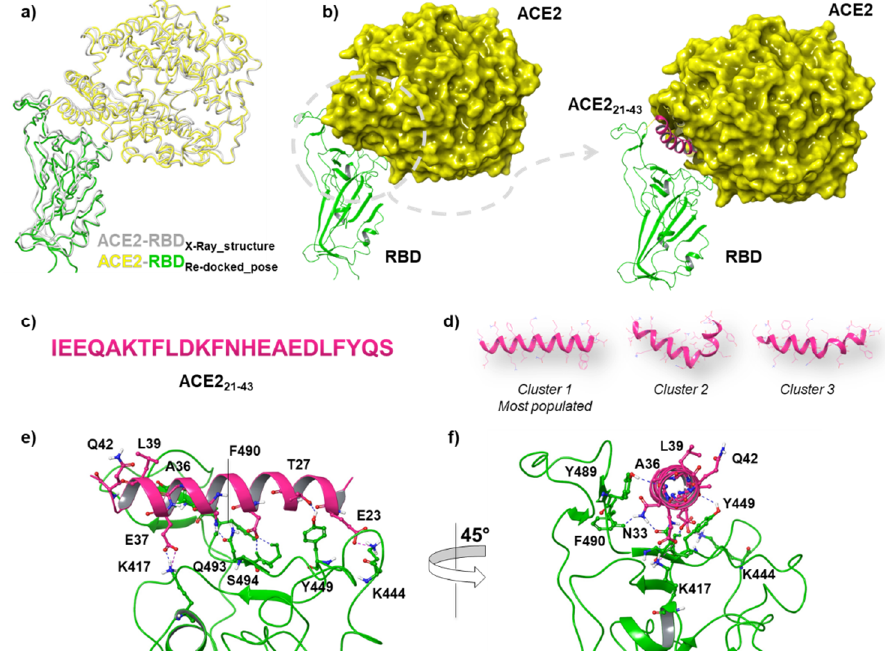
Figure 2. ( a ) Superposition between the X-ray structure of ACE2 in complex with RBD and the best re-docked pose after docking simulations through the HADDOCK tool. ( b ) Right-hand images show zoomed-in context of the ACE2 21–43 peptide at the interface between ACE2 and RBD. ( c ) Linear sequence of a truncated portion (21 to 43 aa) of the ACE2 receptor. ( d ) Three-dimensional (3D) rep- resentation of the three representative clusters of ACE2 21–43 , the first of which is the most populated. Key contacting elements inside ( e ) front view of the RBD-up/ACE2 21–43 conformation, and ( f ) side view of the RBD-up/ACE2 21–43 . All amino acid residues involved in H-bonds (dark blue) and salt bridges (purple) are shown in stick representation. Table 2. Comparison between the cluster statistics of DPP4 270–295 and DPP4 318–343 after molecular recognition with RBD-up conformation through the HADDOCK